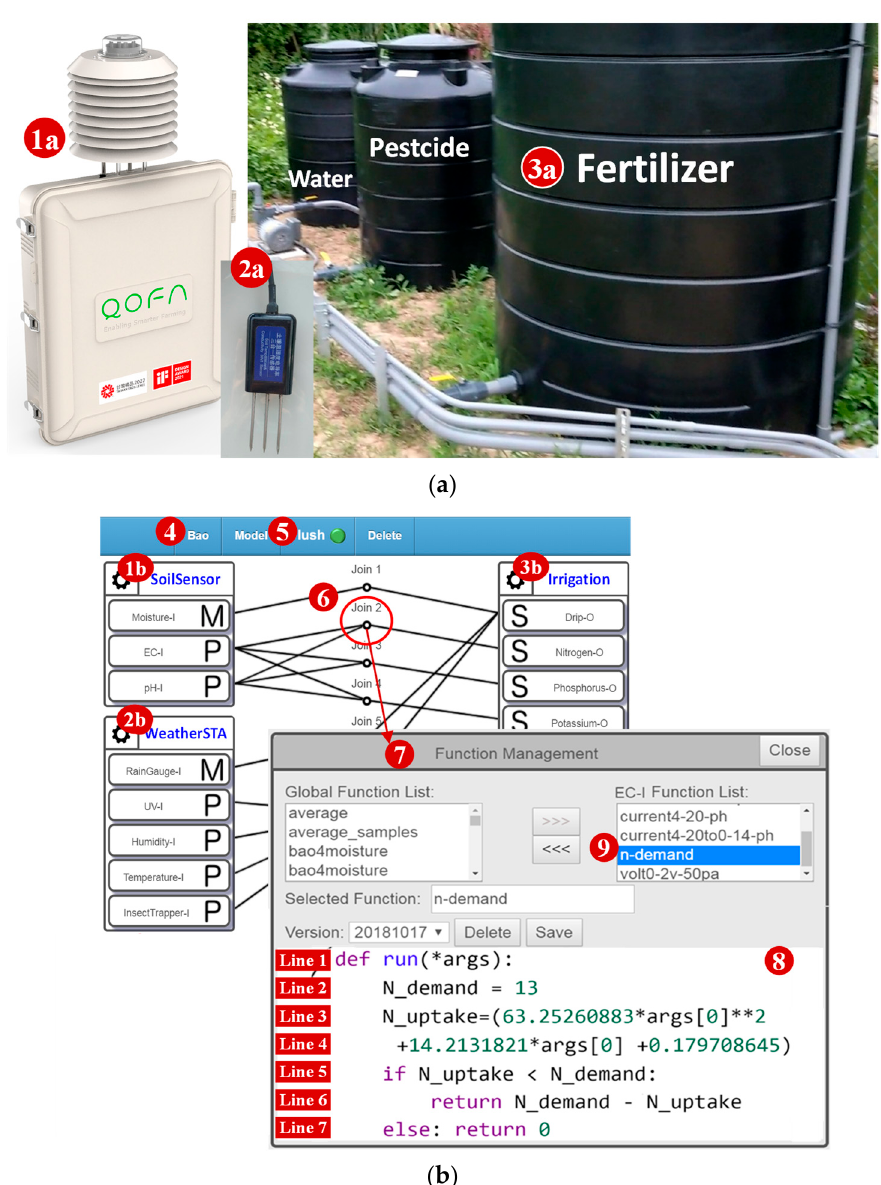
Figure 1. No-code approach for creating a smart agriculture application. ( a ) The physical hardware layout. ( b ) Application creation through LCNC.